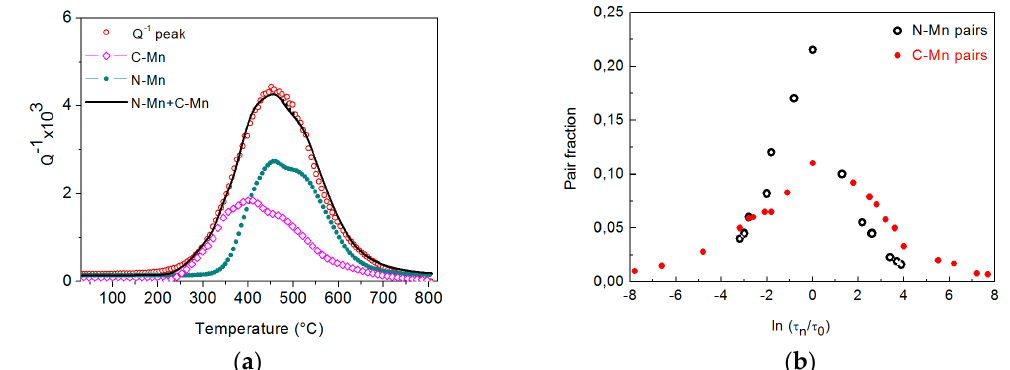
Figure 5. ( a ) Fitting of the broad Q − 1 peak of as-prepared steel. ( b ) Distributions of relaxation times τ n used to get the best fit displayed in ( a ).